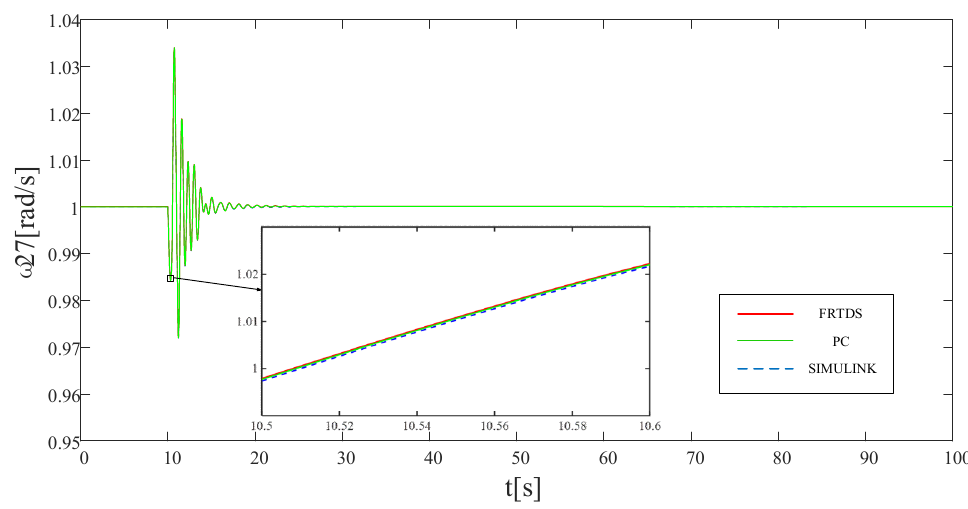
Figure 14. The rotor angular velocity of the generator connected to bus 27.